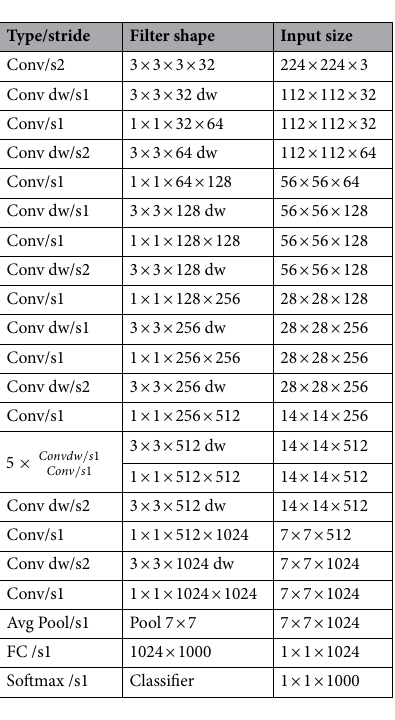
Table 1. MobileNet body architecture 27 .